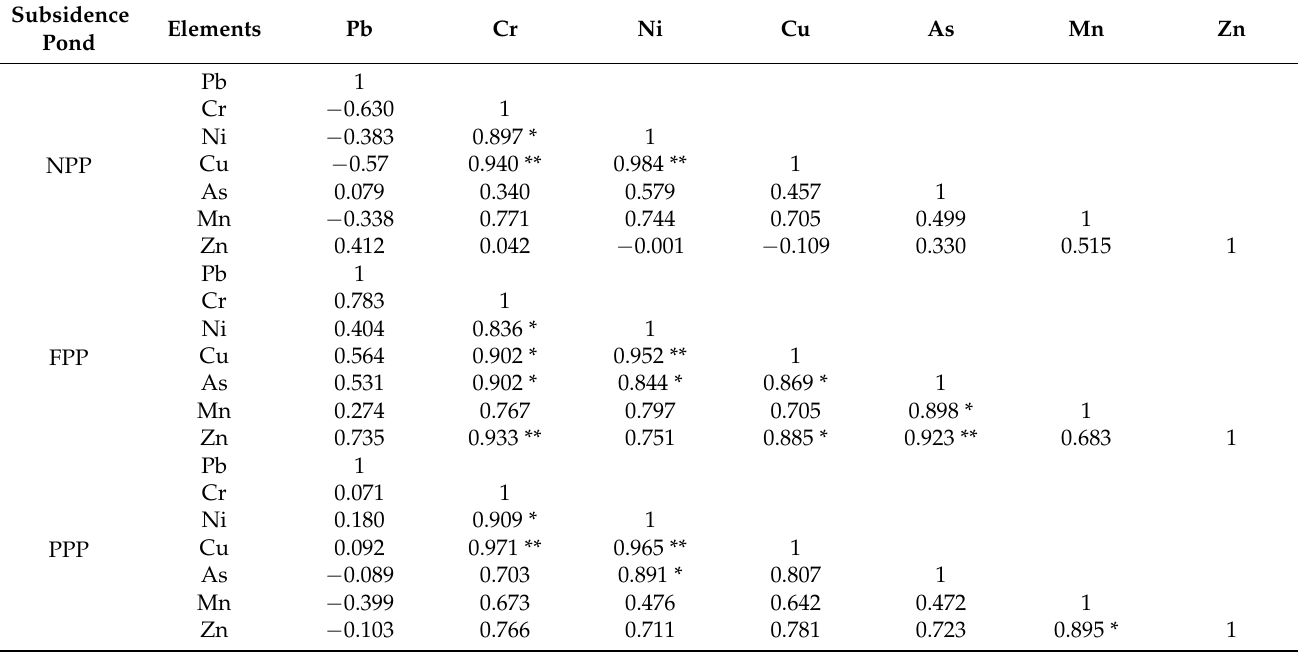
Table 2. Correlation coefficient matrix of heavy metals in different subsidence